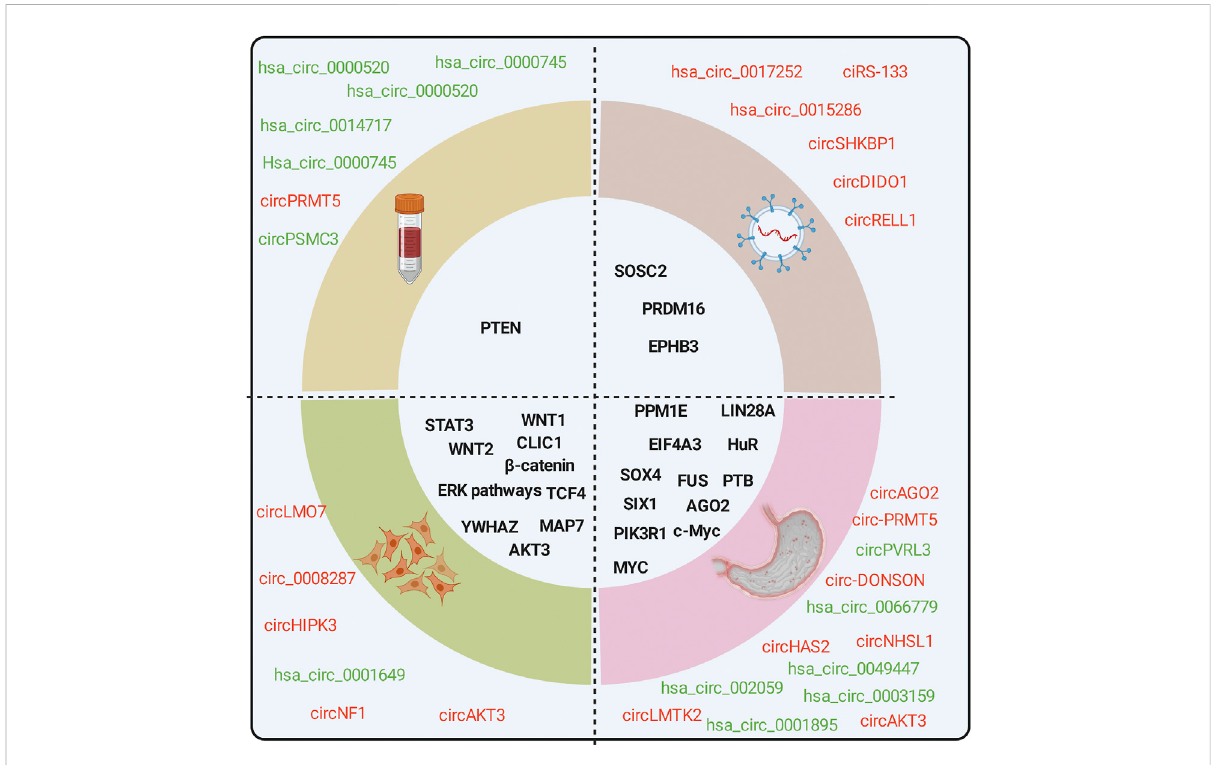
FIGURE 2 CircRNAsareassociatedwiththehallmarksofGC.CircRNAsaredifferentiallyexpressedinGCtissues,cells, exosomes, andbloodfrompatients with GC compared with normal controls. Red for upregulation, green for